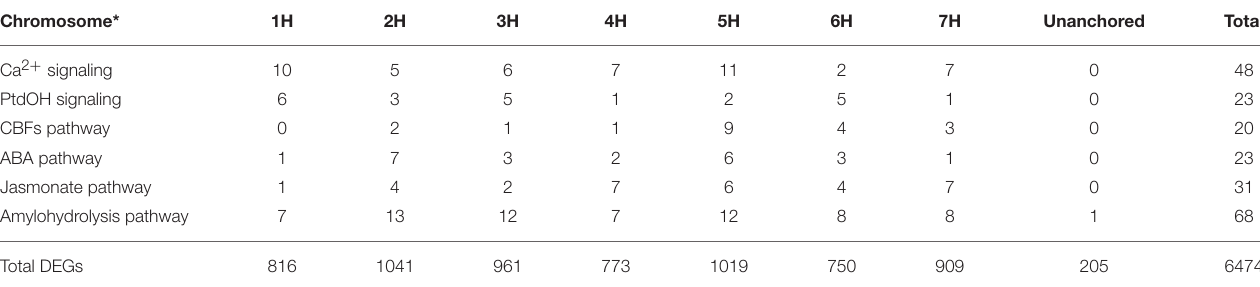
TABLE 1 | Chromosome distribution of differentially expressed genes (DEGs) in low temperature signaling pathways. Chromosome* 1H 2H Ca 2 + signaling PtdOH signaling ABA pathway